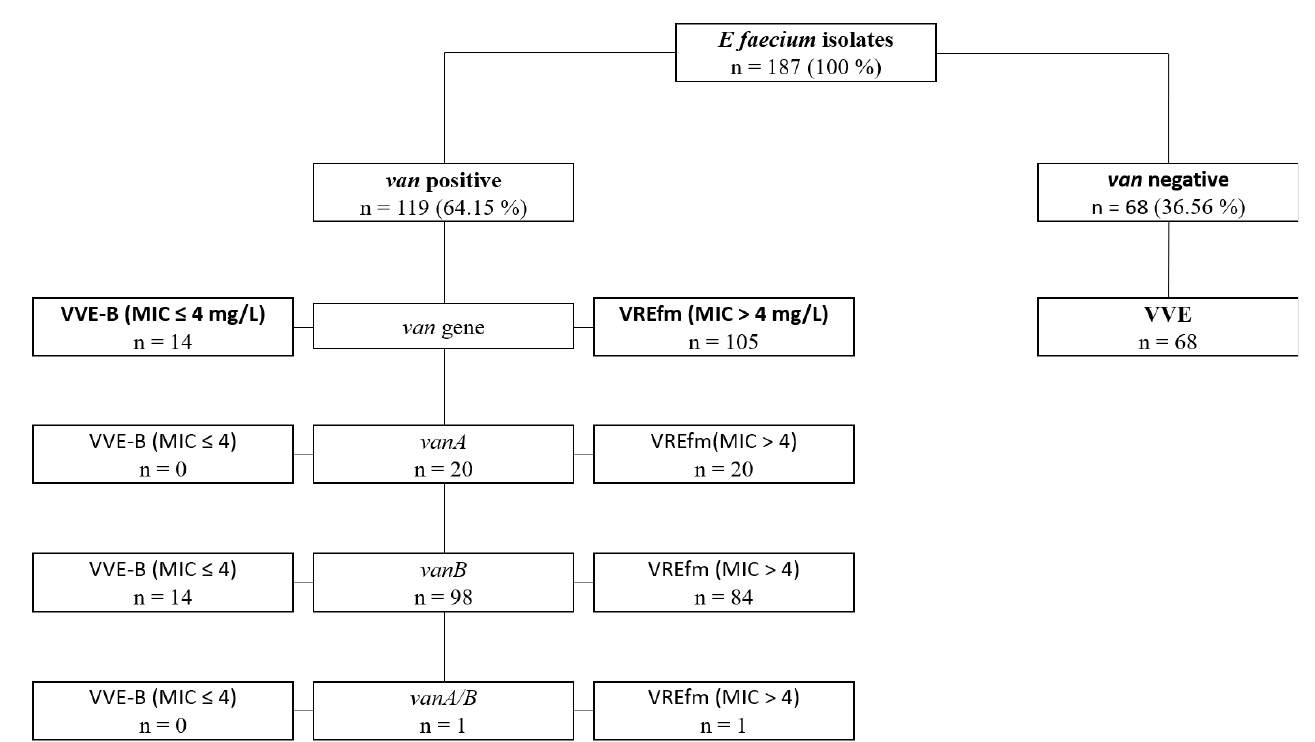
Figure 1. Overview of E. faecium strains. Overview of characteristics of all E. faecium strains included in the study. [VREfm: high-level vancomycin-resistant E. faecium ; VVE-B: phenotypically tested vancomycin-susceptible E. faecium strains harbouring a van B-gene; VSE: vancomycin-susceptible E. faecium ; MIC - minimal inhibitory concentration].